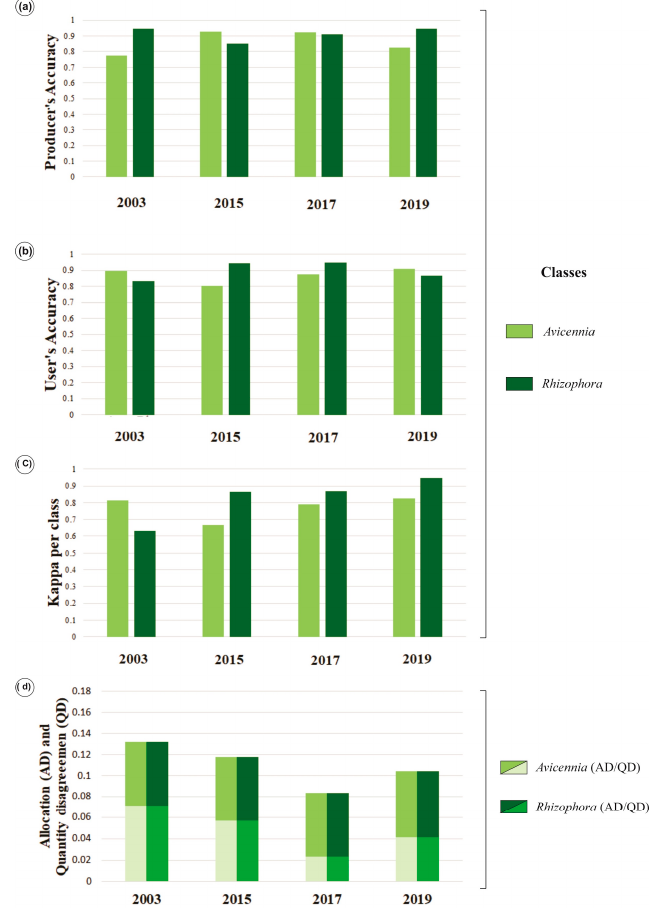
Figure 6. Level 3 accuracy statistics: ( a ) Producer’s and; ( b ) user’s accuracy per class for 2003, 2015, 2017, and 2019 imagery; ( c ) Kappa index); ( d ) allocation and quantity disagreements.